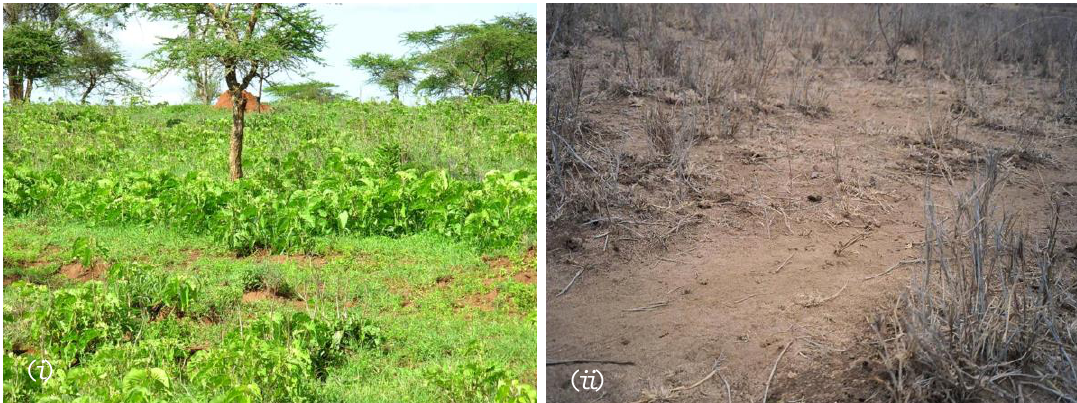
Figure 5. Vegetation of differing palatability at the ecosystem-scale (finer spatial scale) in Namanga Division. ( i ) = high coverage of unpalatable lush C 3 -herbaceous than of palatable C 4 -grass during rainy season in 2007; ( ii ) = dry fibrous C 4 -grass at the height of an extreme drought in 2005. Photo Credit: Margaret Mwangi.